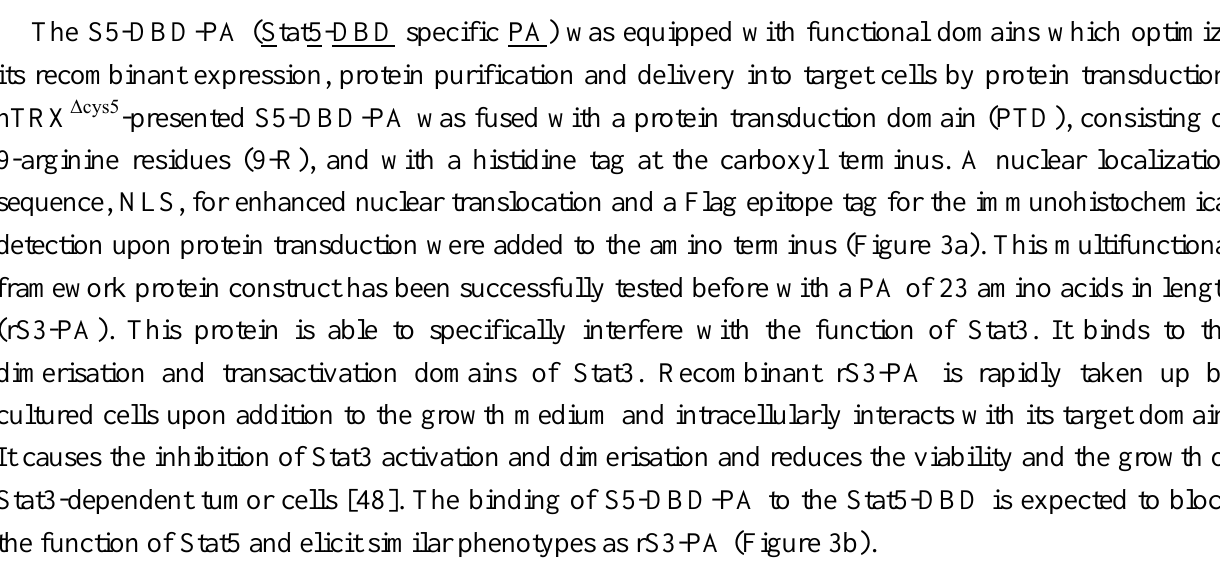
Figure 3. Domain structure of the S5-DBD-PA protein construct used for viral and